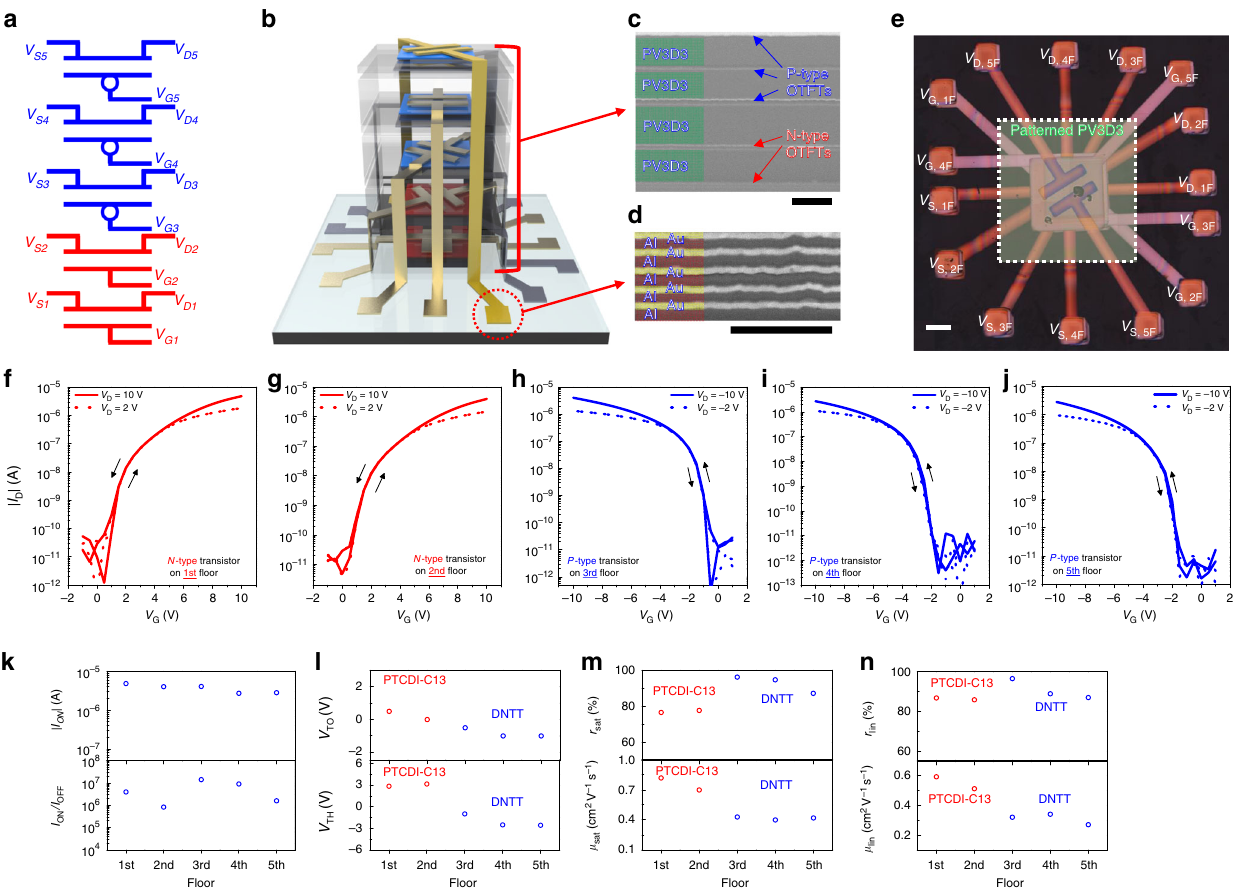
Fig. 3 5-layer 3D-stacked OTFT. a Schematic of a 5-layer 3D-stacked OTFT. b Schematic of a 5-layer 3D-stacked OTFT. Cross-sectional SEM images of c a 3D-stacked OTFT, scale bar, 1 µ m, and d interconnected metal electrodes, scale bar, 500 nm. e An optical micrograph image of a 5-layer 3D-stacked OTFT, scale bar, 400 µ m. Transfer characteristics of the 3D-stacked f PTCDI-C13 n-type transistor at 1 F, g PTCDI-C13 n-type transistor at 2F, h DNTT p-type transistor at 3 F, i DNTT p-type transistor at 4F, j DNTT p-type transistor at 5F. k On/off current ratio and on-current values at | V G | = 10 V. l Threshold and turn-on voltage ( V ON ) values. The extracted carrier mobility and reliability factor values m in the saturation regime and n the linear OTFT were extracted (Fig. 3m, n) 38 . The reliability factor values for the linear and saturation regions simply represent how the transfer curves correspond with the ideal curves and were calculated using